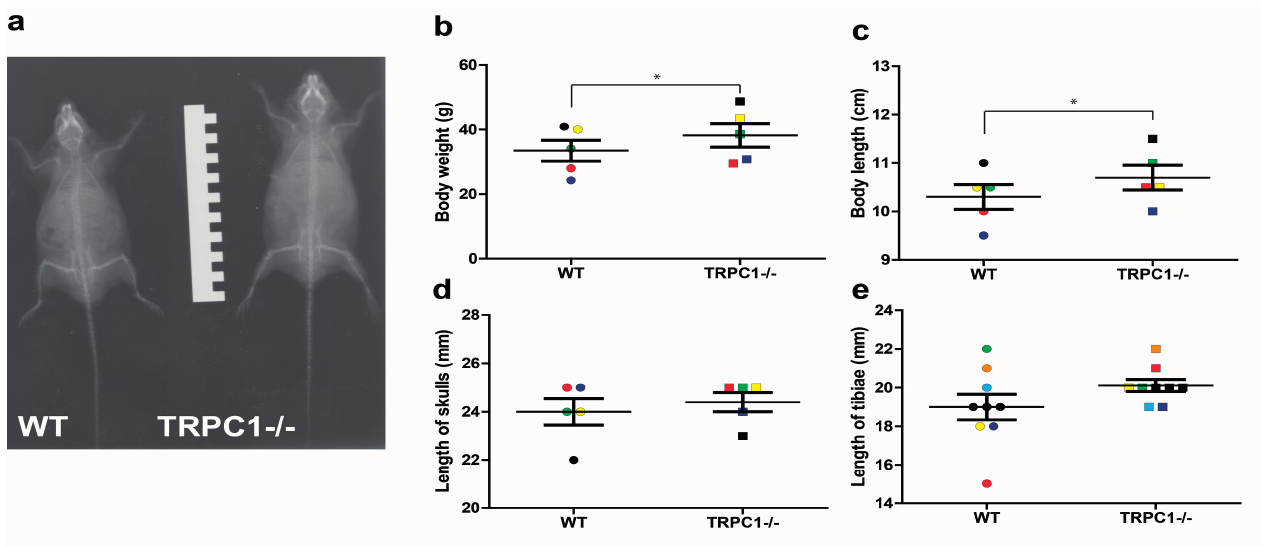
Figure 2. ( a – e) Morphological analysis of TRPC1-/- mice in comparison to WT mice. ( a ) X-ray of TRPC1-/- and WT male littermates 10 months old (ruler marks: 0.5 cm). ( b , c ) Analysis of body weights ( b ) and body lengths ( c ) of 2–10 months old male littermates. Colors label littermates (*, p = 0.0135 and p = 0.0161 in a paired Student’s t-test, respectively). ( d , e ) Analysis of skull lengths ( d ) and tibiae lengths ( e ) in 2–10 months old male and female littermates. Colors label littermates (data are not significant different in a paired Student’s t -test). Lines indicate mean and standard error of the mean (SEM). Data